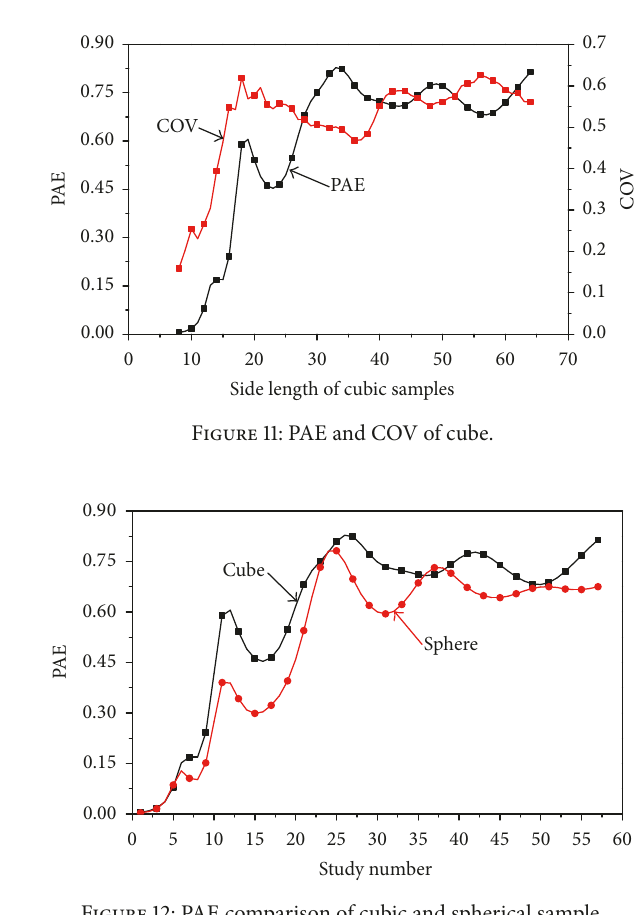
Figure 12: PAE comparison of cubic and spherical sample.